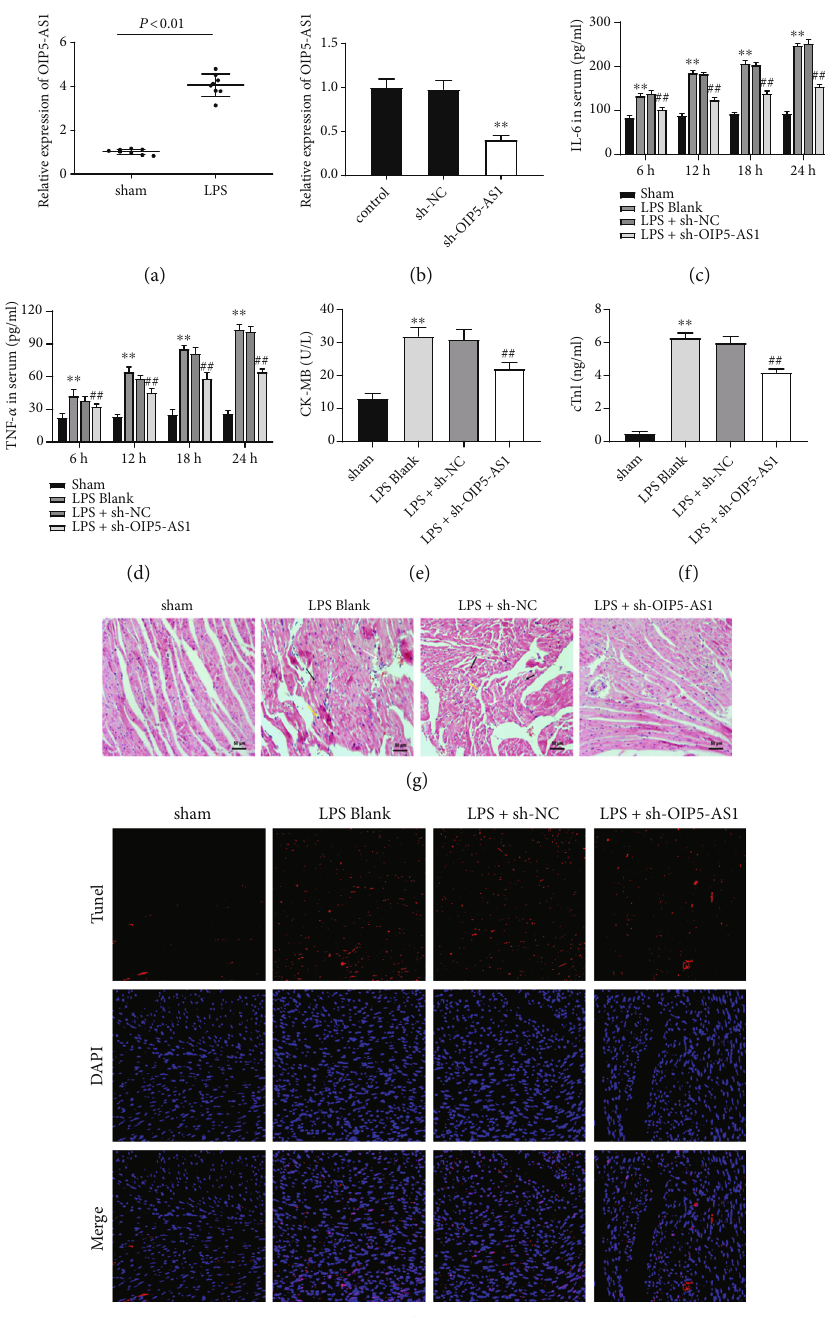
Figure 2: OIP5-AS1 is up-regulated by LPS in myocardial tissues, and knockdown of OIP5-AS1 suppresses LPS-induced in fl ammation in rats. (a) Relative expression of OIP5-AS1 in myocardial tissues of LPS-induced rats was determined by qRT-PCR. P < 0 : 01 versus sham. (b) The e ffi ciency of OIP5-AS1 knockdown in myocardial tissues was determined by qRT-PCR. ** P < 0 : 01 versus control. (c – f) The levels of IL- 6, TNF- α , CK-MB, and cTnl in the serum of LPS-induced rats were measured by ELISA. ** P < 0 : 01 versus sham. ## P < 0 : 01 versus LPS+sh- NC. (g) H&E was used to evaluate morphological changes in myocardial tissues of LPS-induced rats. Black, white, and yellow arrows indicated eosinophils, neutrophils, and lymphocytes, respectively. Scale bar =50 μ m. Magni fi cation: 200 × . (h) TUNEL staining